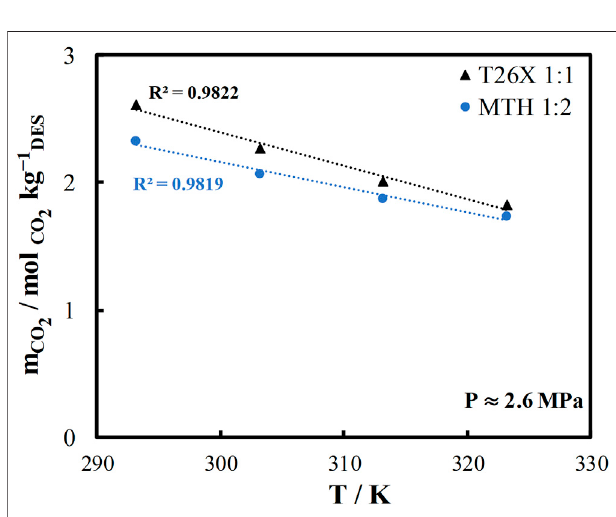
FIGURE 4 | Temperature dependence of carbon dioxide solubility at medium pressure ~2.6 MPa in L-menthol/thymol (MTH) and thymol/2,6- xylenol